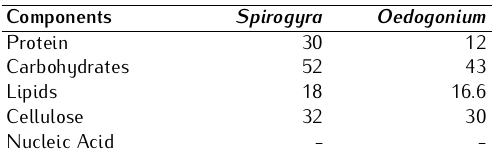
Table 1. The chemical composition of tested algae expressed on a dry weight (%). Components Spirogyra